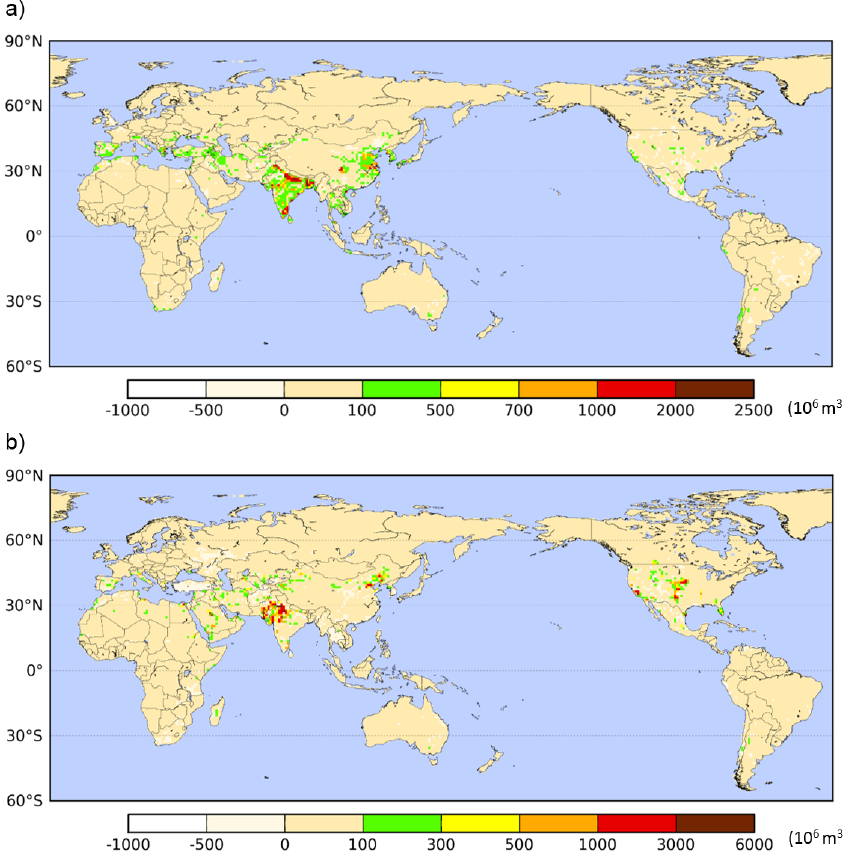
Figure 6. Distributions of the differences in MSR WFD (10 6 m 3 ) between 1960 and 2000 (a) and the differences in NNBW WFD (10 6 m 3 ) between 1960 and 2000 (b)